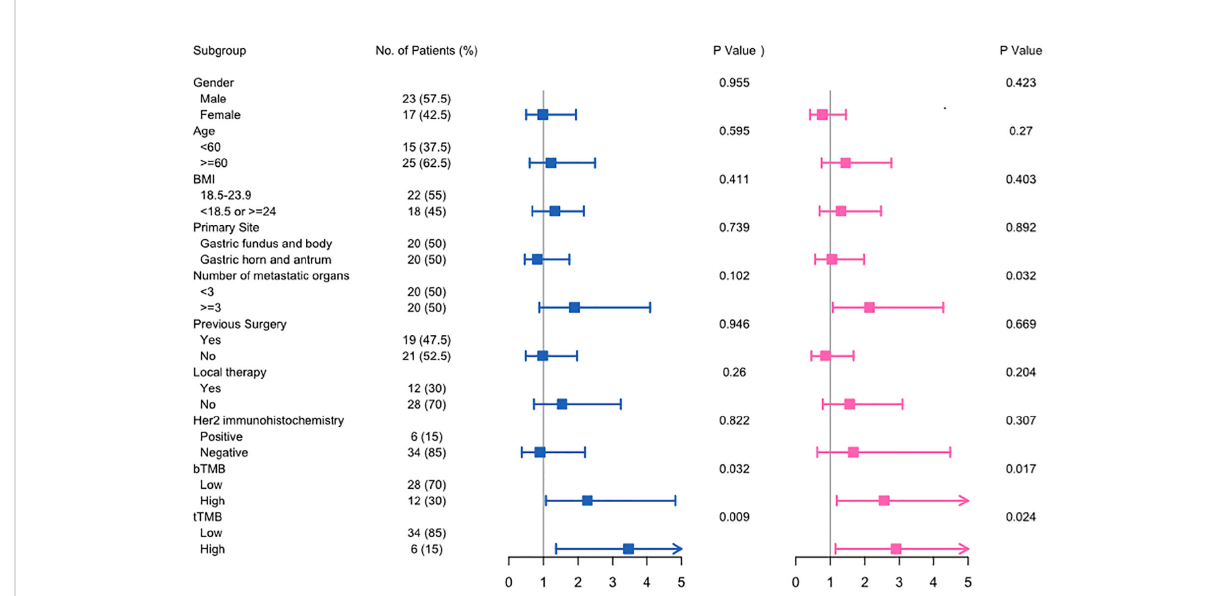
FIGURE 4 The univariate Cox analysis of clinicopathological factors for overall survival (left) and progression-free survival (right) in advanced gastric